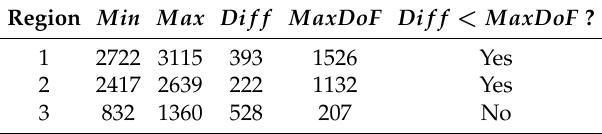
Figure 6. Depth map segmentation using the standard graph-based segmentation algorithm and our modified graph-based segmentation algorithm. ( a ) Raw depth map of a real scene. ( b ) Colour image of the scene. ( c ) Segmentation result by using the standard graph-based Felz algorithm. ( d ) Segmentation result using our modified algorithm. Table 1. Depth values (in mm) of segmented regions in Figure